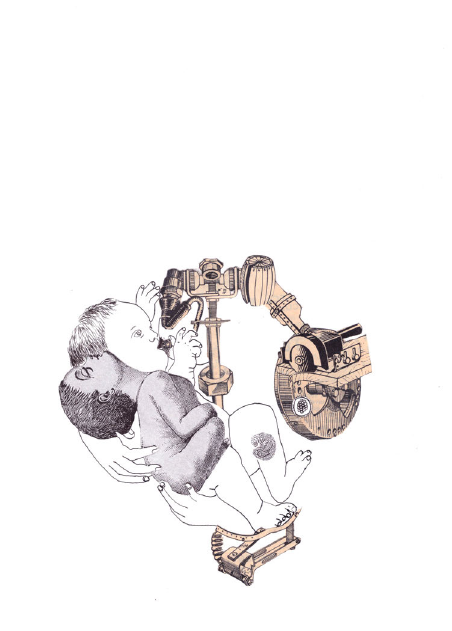
FFigigururee 77 And she thrived on being breastfed. Ever since she was a newborn, Alison had a great appetite, I always breast fed her and am still breast feeding.